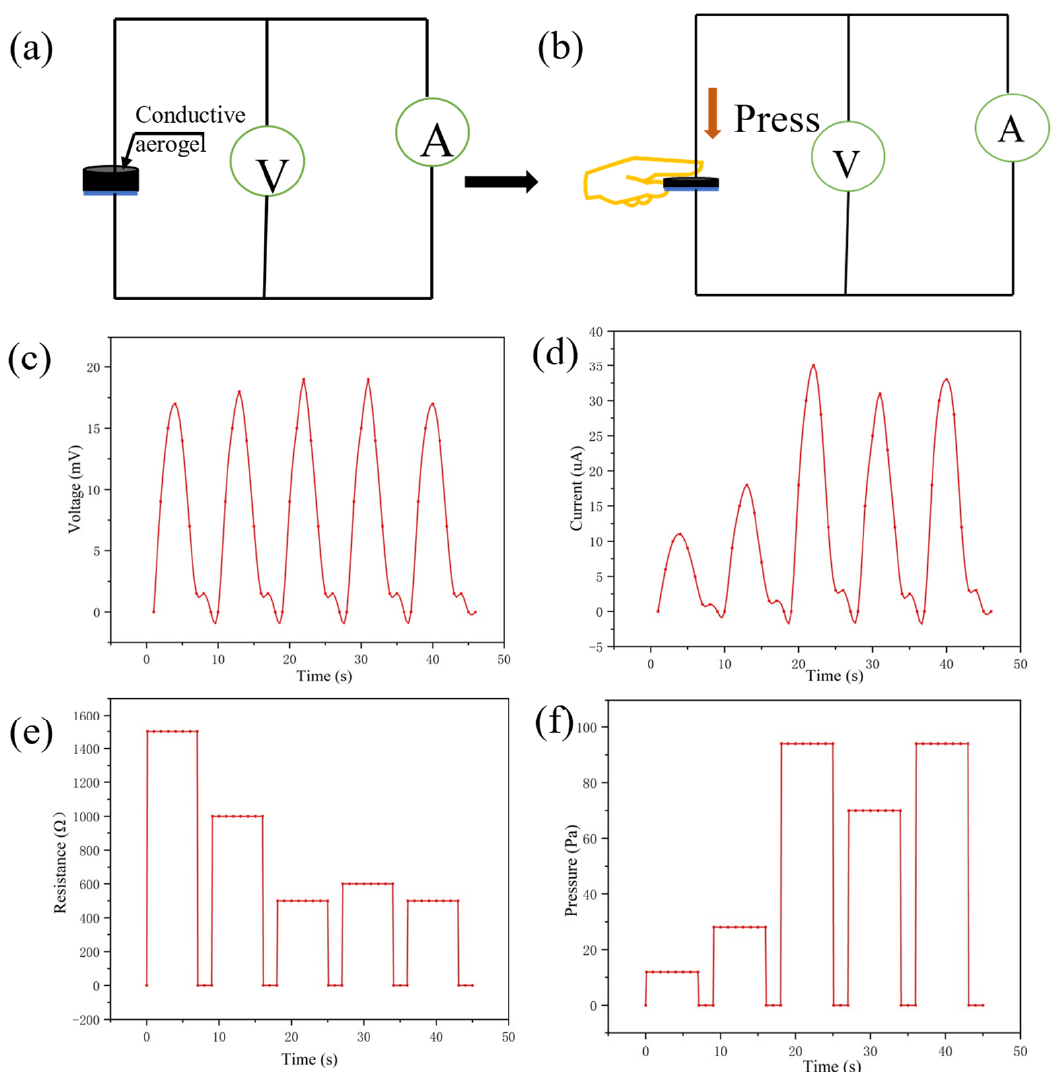
Figure 6. ( a ) Test circuit of the self-powered sensor; ( b ) the index finger pressed the conductive aerogel with different strengths; ( c , d ) changes in voltage and current during pressing; ( e , f ) changes in electric resistance and applied pressure during pressing.